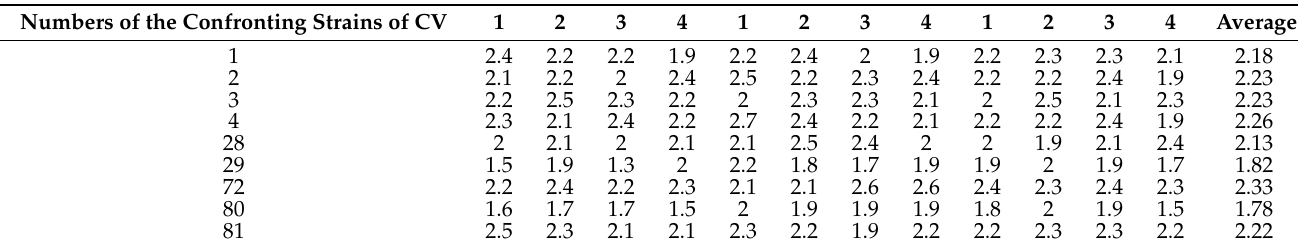
Table A1. Diameter of the inhibition zone of the strains against Coriolus versicolor. The data in one row are three sets of replicates of the same strain.